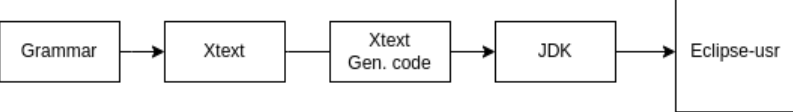
Figure 6. Implementation of REX in Eclipse-dev.